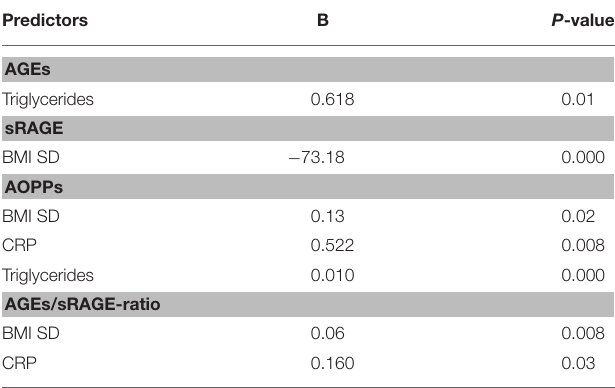
TABLE 4 | Statistically significant associations at multivariate stepwise regression analysis for BMI SD, HOMA-IR, TC/HDL-ratio, LDL, Triglycerides, uric acid,